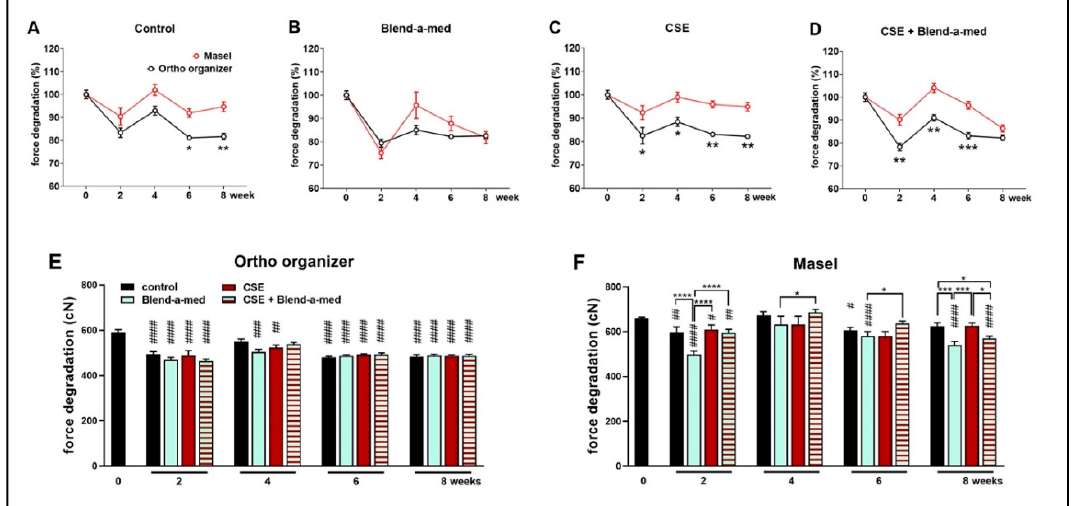
Figure 5. Percentages of force degradation of ( A ) control, untreated; ( B ) Blend-a-med; ( C ) cigarette smoke and ( D ) cigarette smoke + Blend-a-med treated Ortho organizer (black) and Masel (red) elastic chains at 50 mm extension. Force degradation of ( E ) Ortho organizer and ( F ) Masel elastic chains to different external factors in cN n = 6/group; two-way ANOVA and Sidak post hoc tests, * p < 0.05, ** p < 0.005, *** p = 0.0005 vs. Masel. Two-way ANOVA and Tukey post hoc tests. # p < 0.05, ## p < 0.005, ### p < 0.0005, #### p < 0.0001, vs. intact values; * p < 0.05, *** p < 0.0005, **** p < 0.0001 difference between two treatments at given